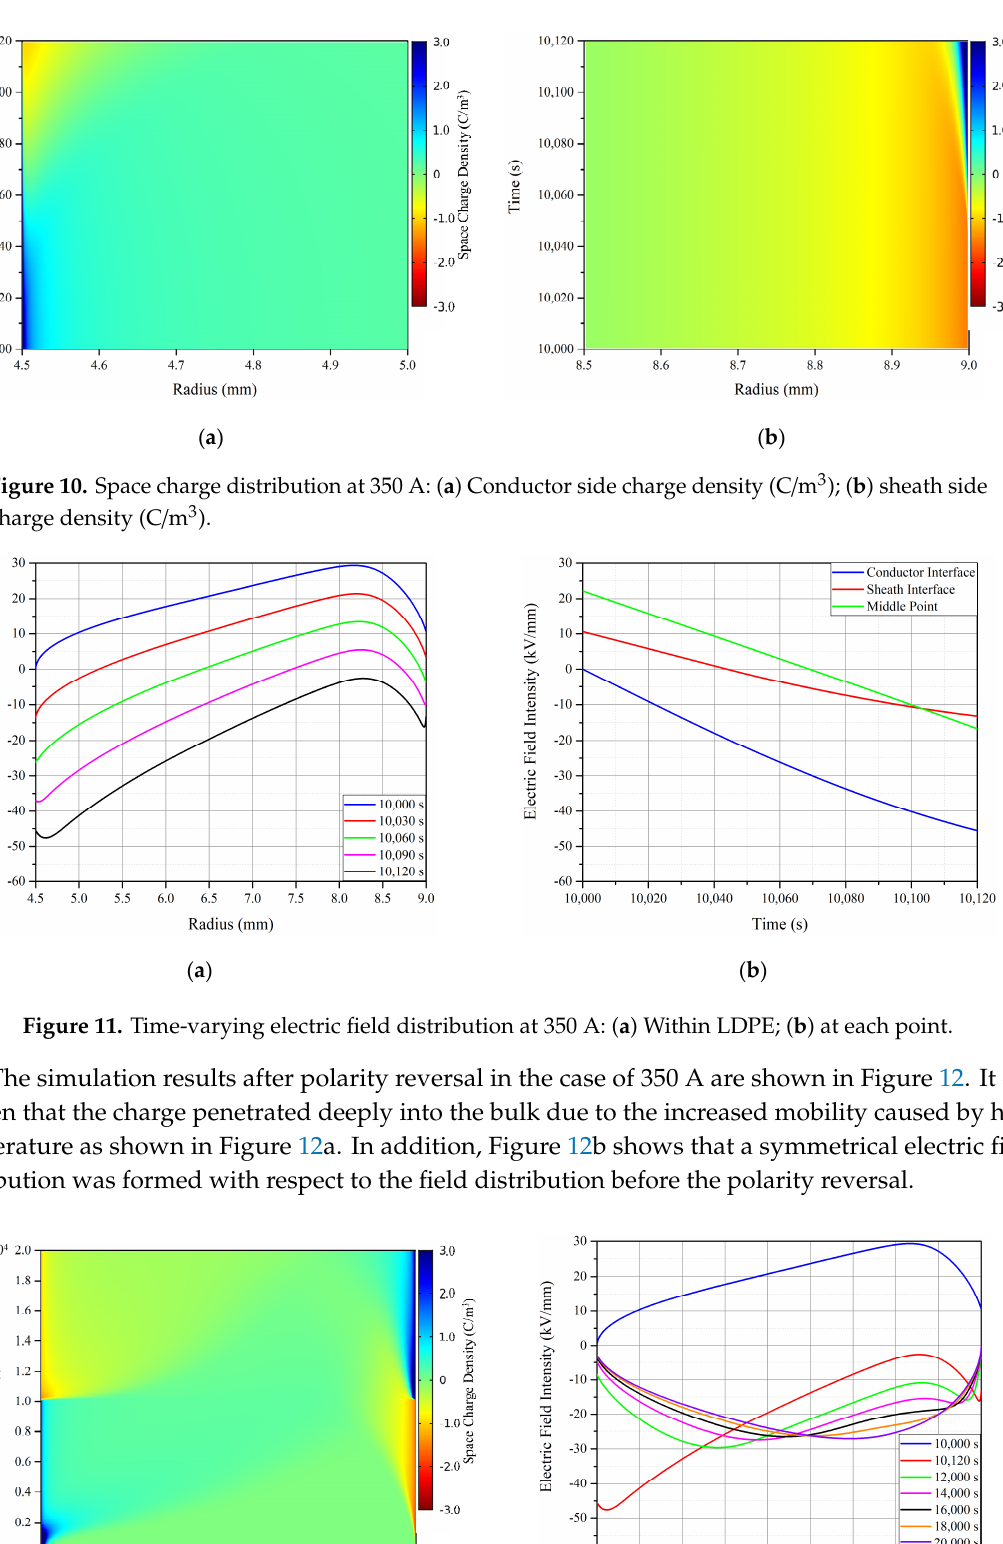
Figure 12. Simulation results after polarity reversal at 350 A: ( a ) Space charge density within LDPE (C/m 3 ); ( b ) time-varying electric field distribution.